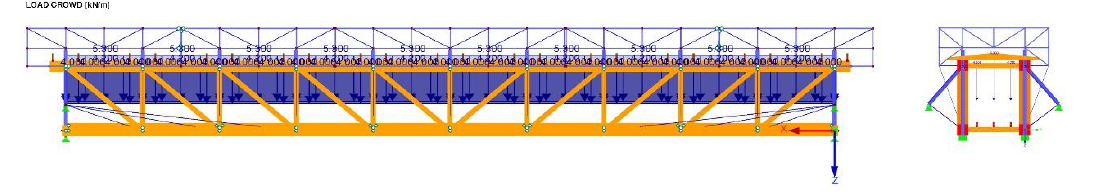
Figure 7. Representation of the crowd load.